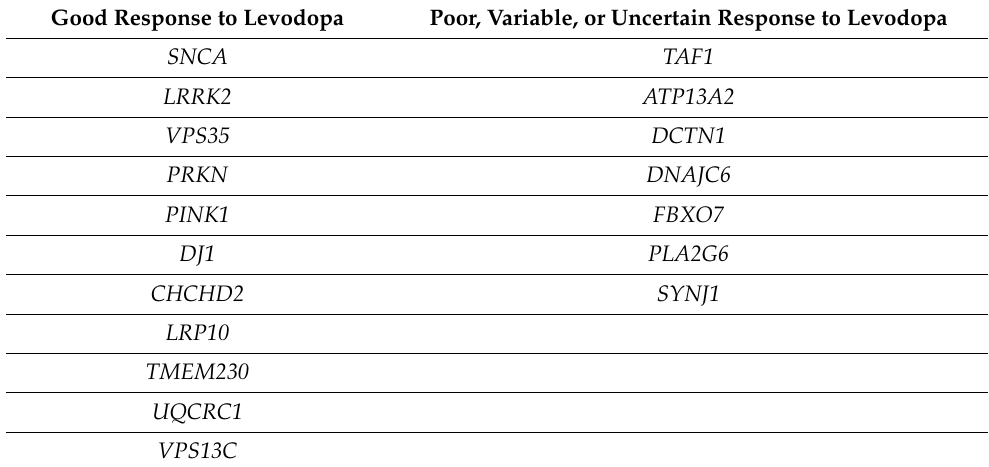
Table 2. Levodopa-responsiveness stratified according to Parkinson’s disease monogenic forms. Good Response to Levodopa Poor, Variable, or Uncertain Response to